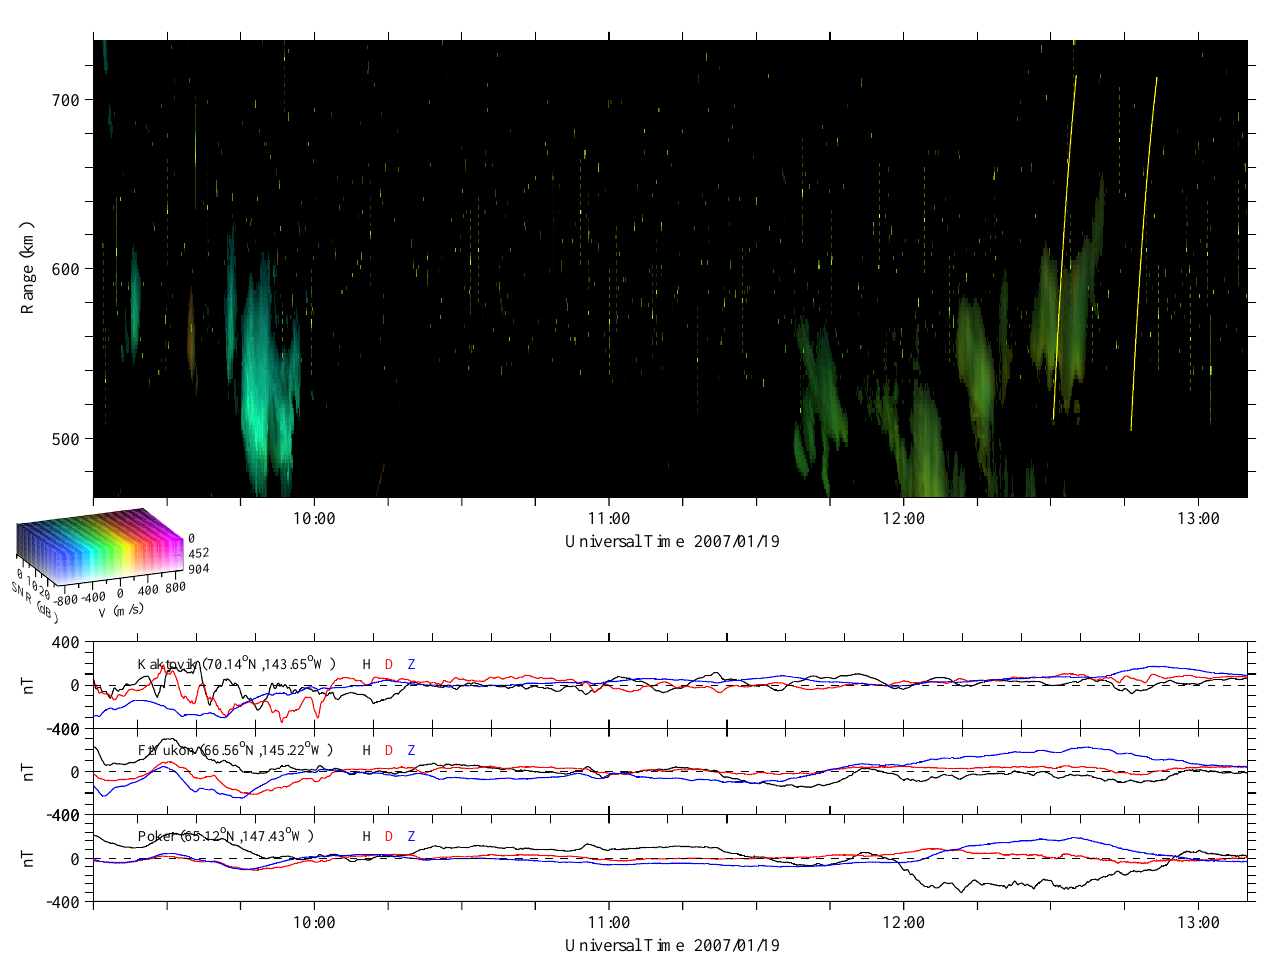
Fig. 2. Range time intensity (RTI) plot of coherent scatter received by the 30MHz imaging radar in Anchorage. The brightness, hue, and saturation of the pixels reflect the signal-to-noise ratio, Doppler shift, and spectral width of the echoes according to the legend shown. The solid curves are the range to the E-region footprints of the trajectories of rockets 36.234 and 21.138. Also shown are magneometer traces for Kaktovik, Ft. Yukon, and Poker